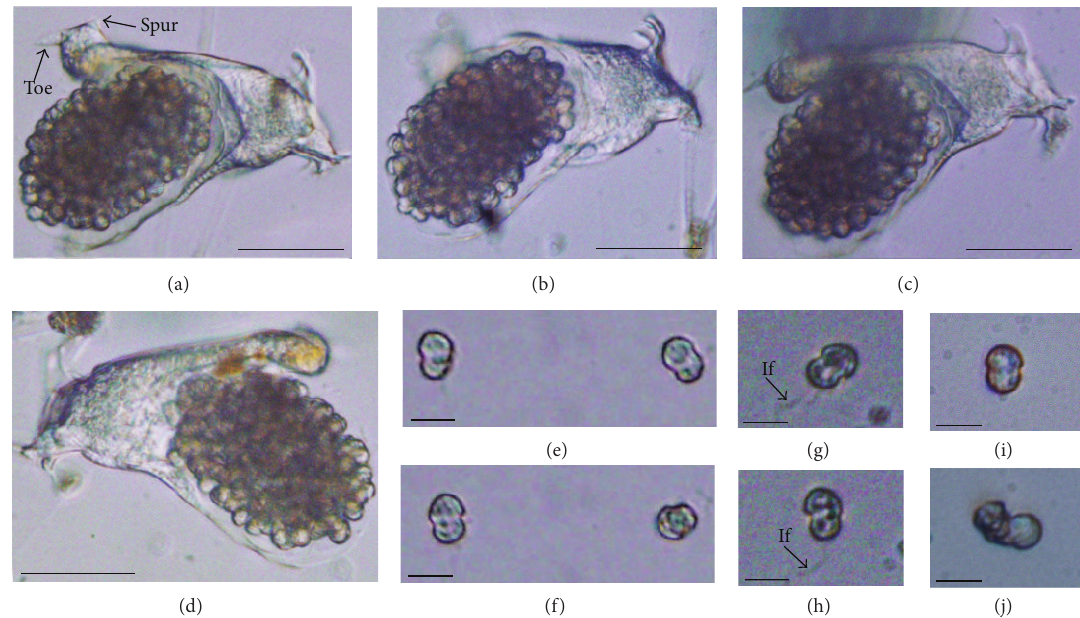
Figure 1: Light microscopy pictures of an undescribed dinokaryotic parasite of a rotifer, tentatively Synchaeta . (a)–(d) Infected host. (e)– (j) Recently released dinospores. lf: longitudinal flagellum. See video in Supplementary Material, http://youtu.be/WosjATyy1DE . Scale bars: (a)–(d) 50 𝜇 m; (e)–(j) 10 𝜇